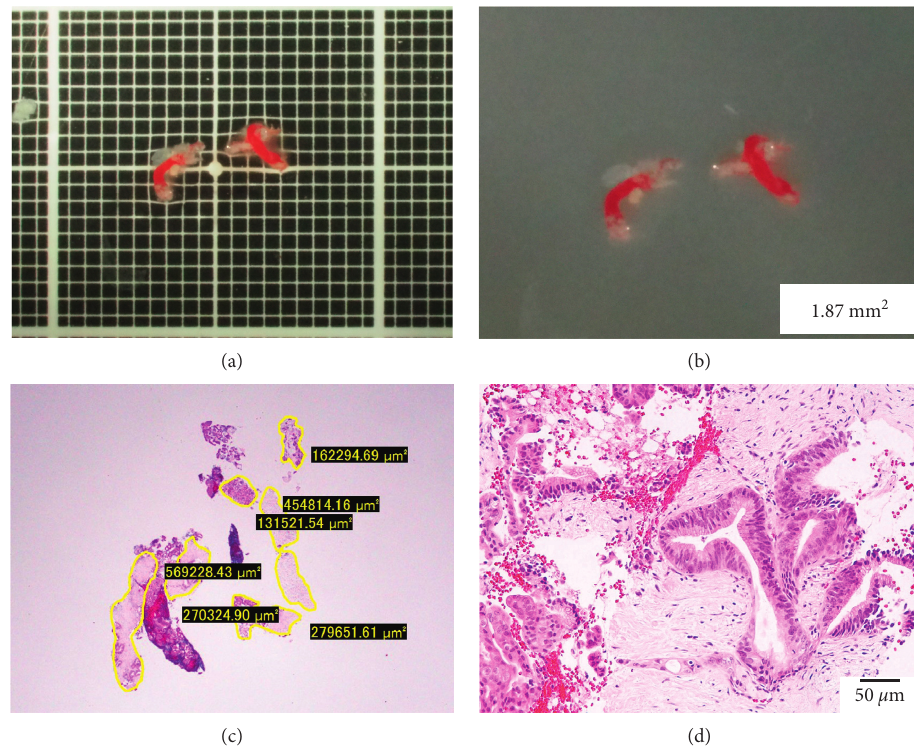
Figure 5: An example where stereomicroscopic observation was considered useful in determining the presence of core tissue. (a, b) A specimen obtained from a mass in the pancreatic body, observed under a stereomicroscope with (a) and without (b) a black scale. The specimen is relatively small, which is difficult to macroscopically evaluate in detail, but under a stereomicroscope, white core tissue is observed in addition to red blood clots. (c) Measurement using imaging software (CellSens) shows that 1.87mm 2 of tissue was collected. (d) Photomicrograph showing a component of atypical cells with enlarged nuclei in the fibrous stroma, consistent with ductal carcinoma of the